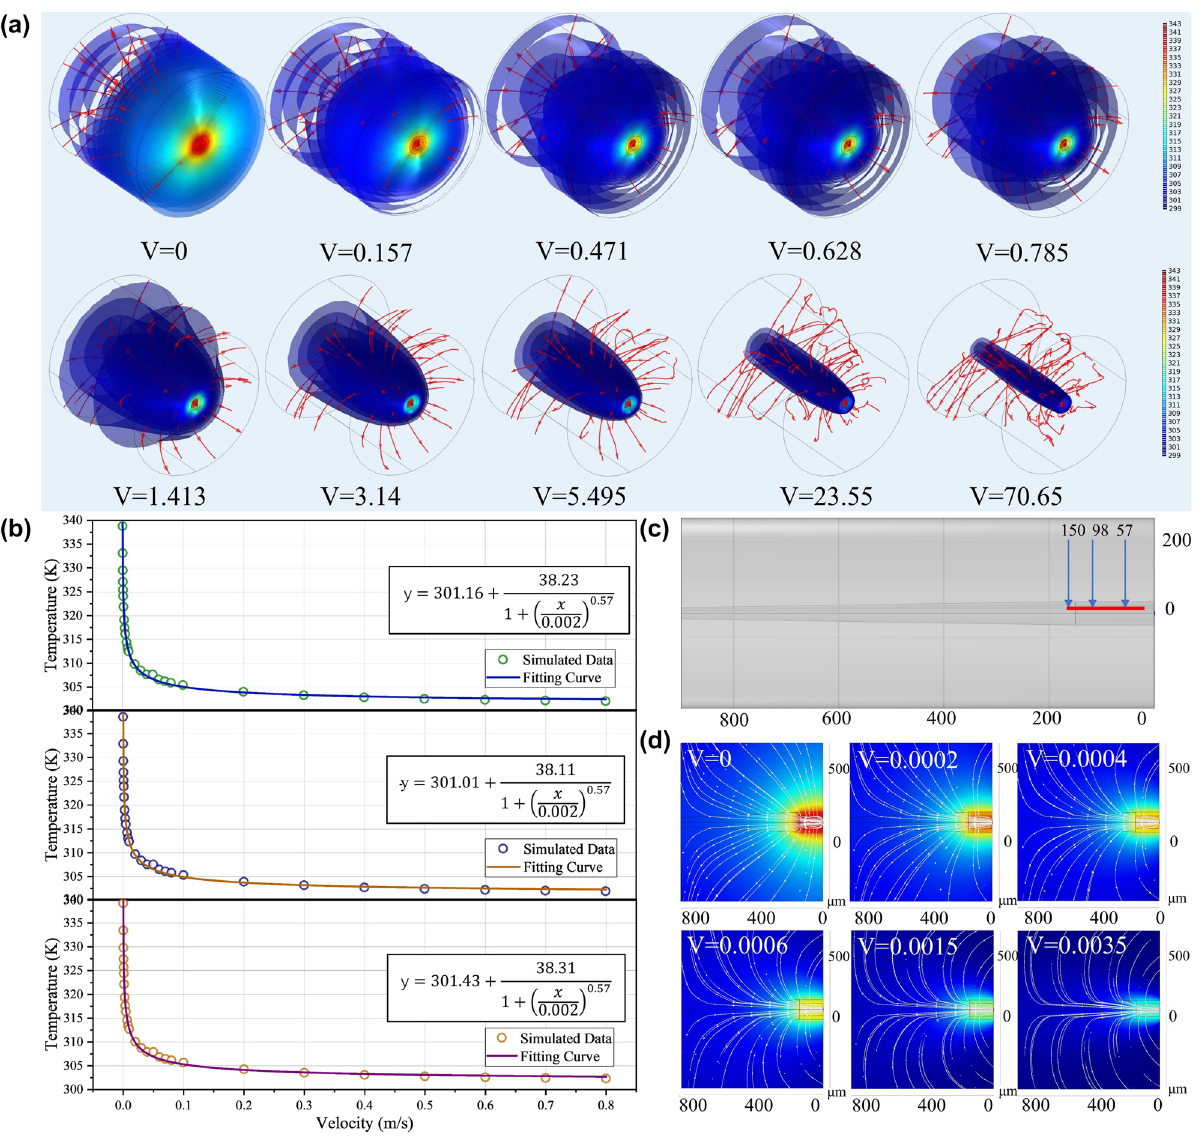
Figure 4: Simulation of the microfluidics flowmeter. (a) The FEA simulation of isothermal surface under different flow velocity. (b) Temperature variation and fitting curve at three point of the central axis under different flow velocity. (c) Sample point. (d) Temperature field section and surface streamline under different flow